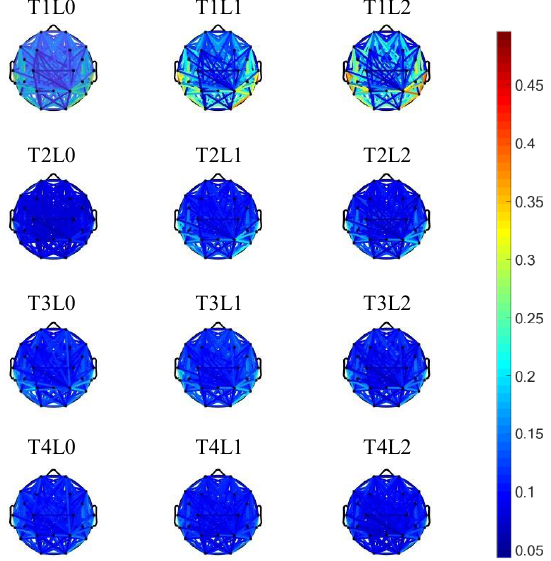
Figure 3. Group average connection strength of channel pairs with significant interaction across different conditions (T for Test, L for Level).